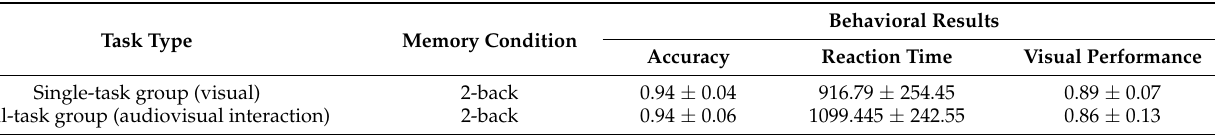
Table 2. Behavioral performance parameters in the single-task group (visual) and dual-task group (audiovisual interaction) were statistically analyzed (mean ± standard